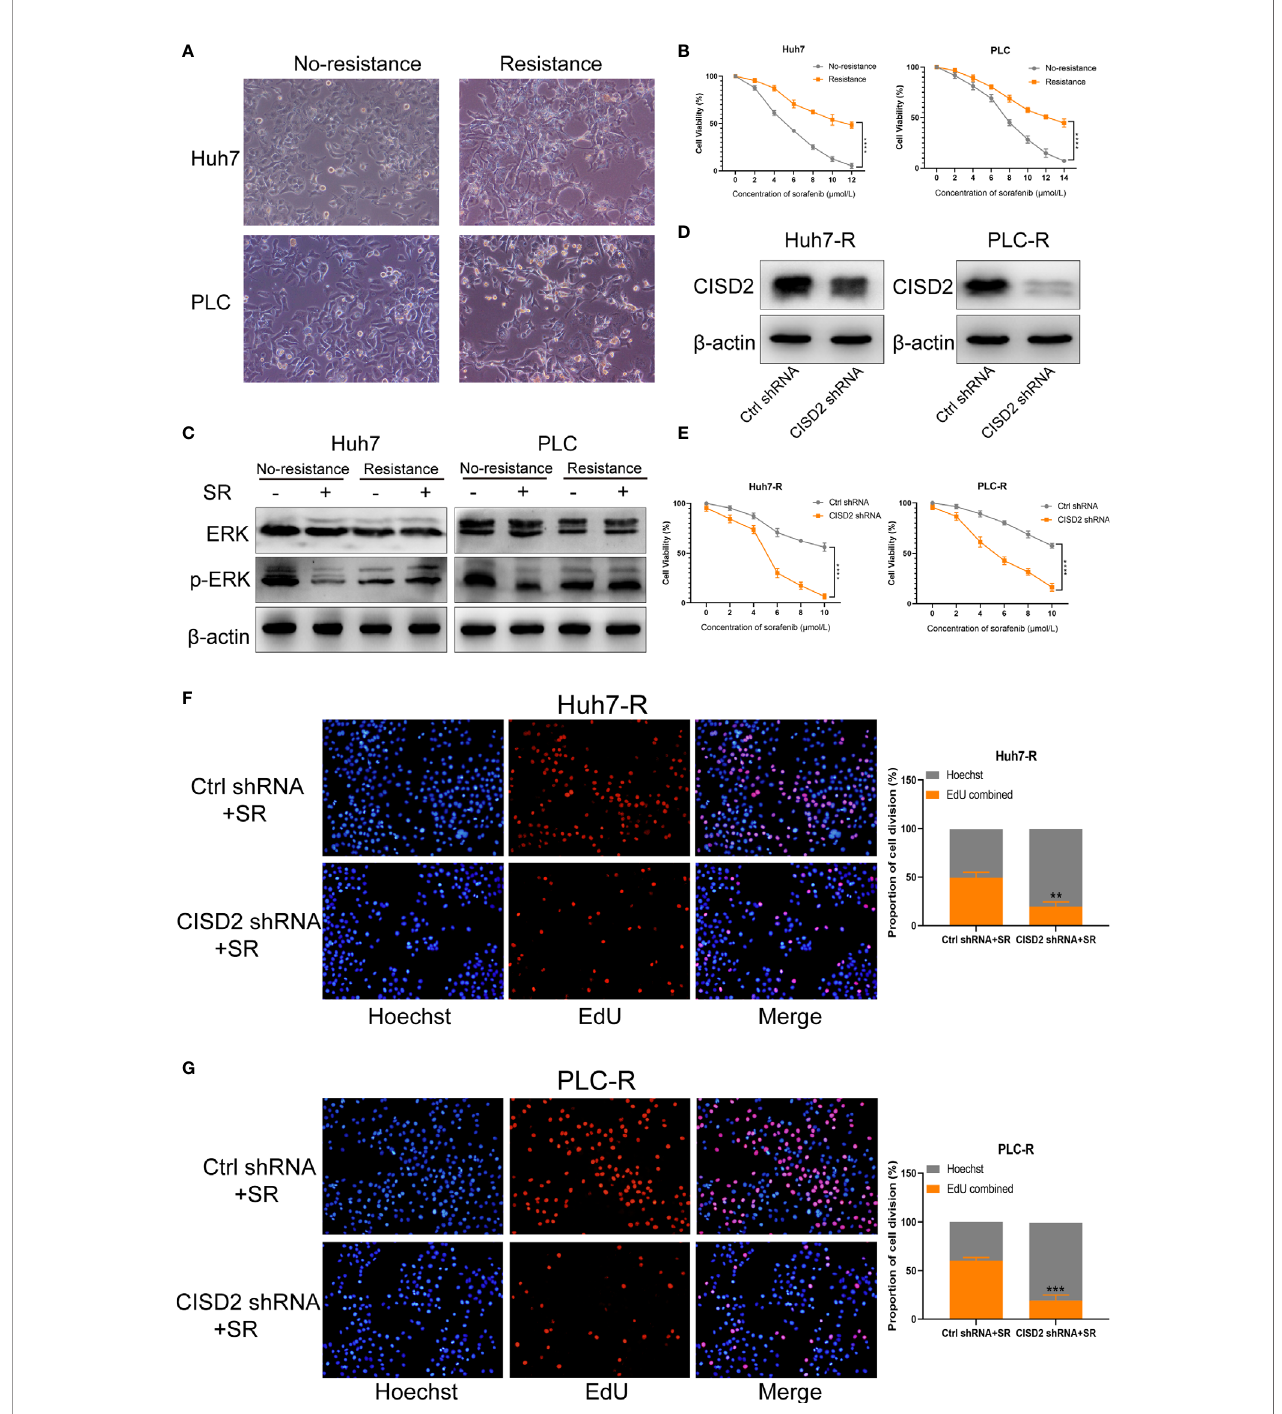
FIGURE 2 | Knockdown of CISD2 reverses sorafenib resistance. (A) Sorafenib-resistant cells were cultured for 6 months by the concentration gradient increasing method, and the morphology of resistant cancer cells was detected. (B) CCK-8 method was used to detect the cell viability under treatment with different concentrations of sorafenib (n = 3, **** P < 0.0001 versus No resistance). (C) Western blot was used to detect the expression level of ERK and p-ERK protein on treatment with sorafenib (SR, 10 m mol). (D) Western blot was used to detect the expression level of CISD2 under transfected CISD2 shRNA or Ctrl shRNA in Huh7- resistant cell (Huh7-R) and PLC-resistant cell (PLC-R). (E) CCK-8 method was used to detect the cell viability with different concentrations of sorafenib under transfected CISD2 shRNA or Ctrl shRNA (n = 3, **** P < 0.0001 versus Ctrl shRNA). (F, G) EdU method was used to detect cell proliferation under treatment with sorafenib (10 m mol) or transfected CISD2 shRNA in resistant cells (n = 3, ** P < 0.01, *** P < 0.001 versus Ctrl